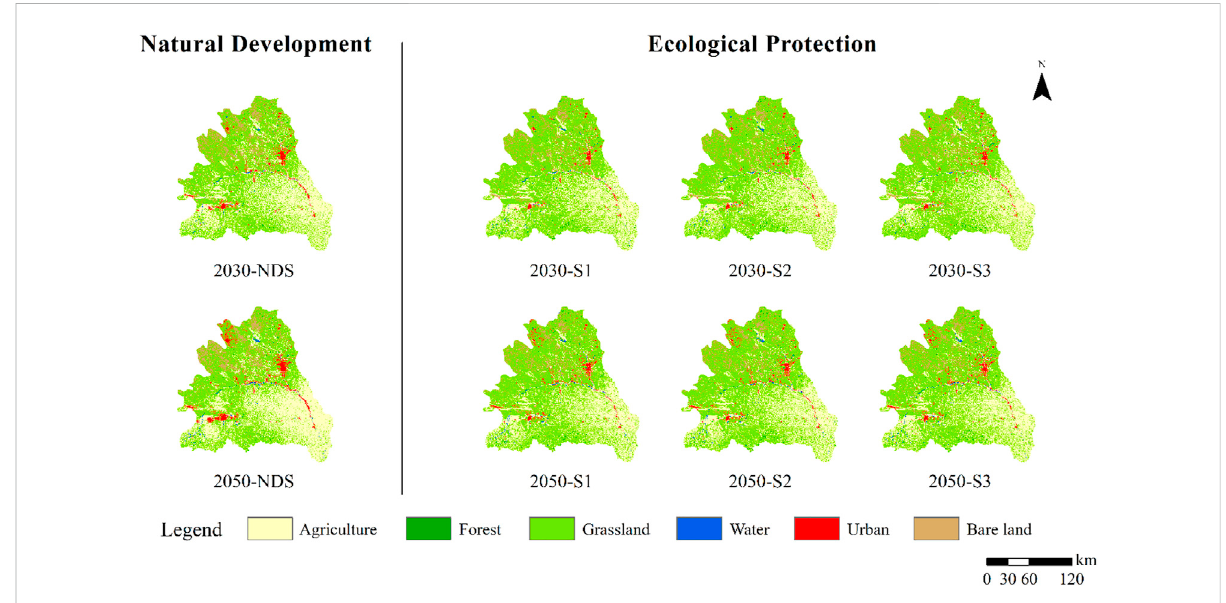
FIGURE 5 Land-use type for different scenarios in 2030 and 2050.